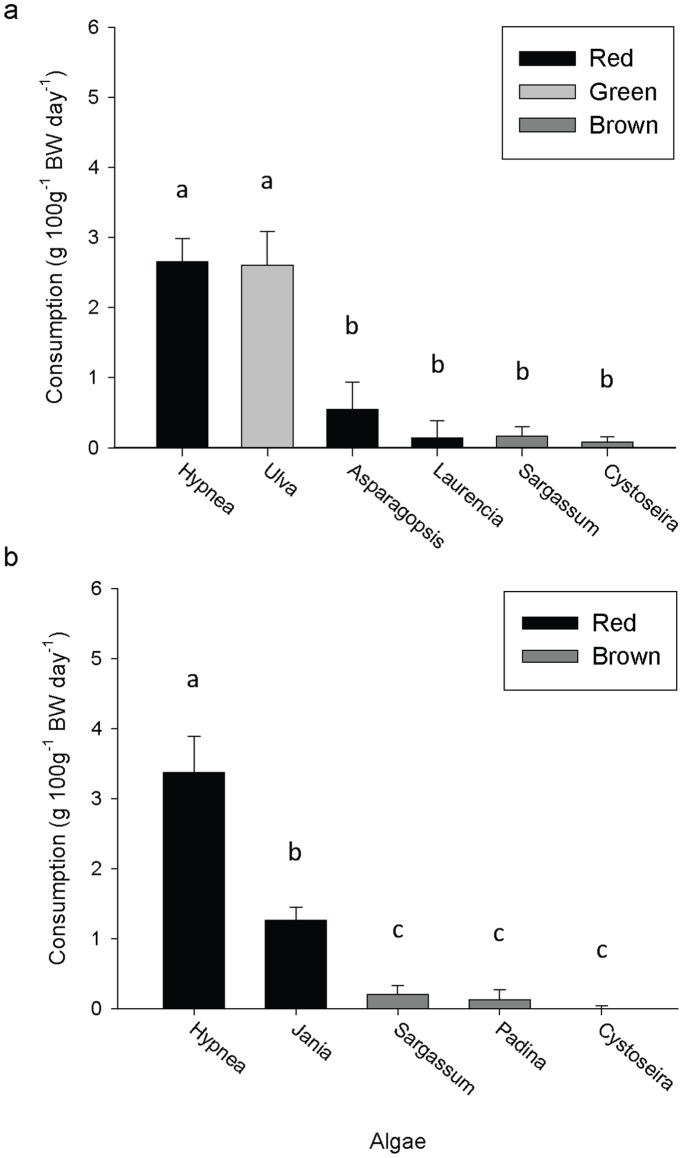
Feeding preferences of H. asinina in two separate multiple choice feeding assays (A & B).Data show mean (+SE) consumption rates of each species (g FW algae day−1) for red, brown and green algae standardised for abalone size (100g−1 BW). A. Preferences between 6 algal species (n = 11) with abalone size range of 35–80 g (mean = 54.26 g). B. Preferences between 5 algal species (n = 19) with a larger abalone size range; 29–184 g (mean = 95.63 g). Common letters above columns indicate no significant difference in preference between treatments for each assay (Friedman’s multiple comparisons, p>0.05).